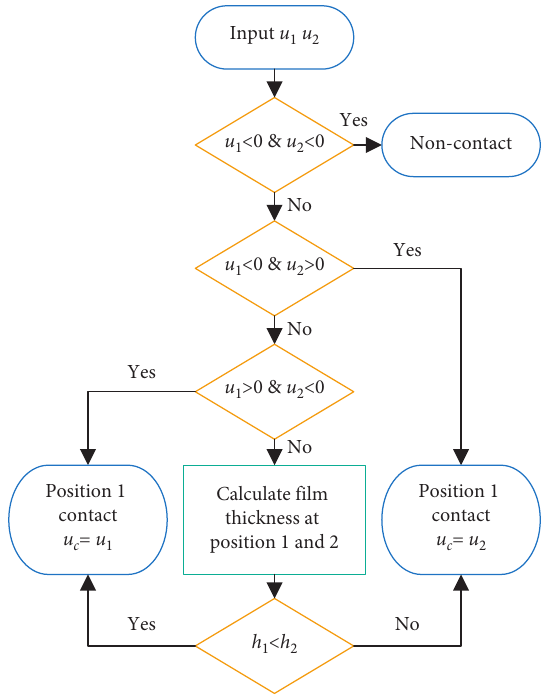
Figure 6: Flow of contact position determination.